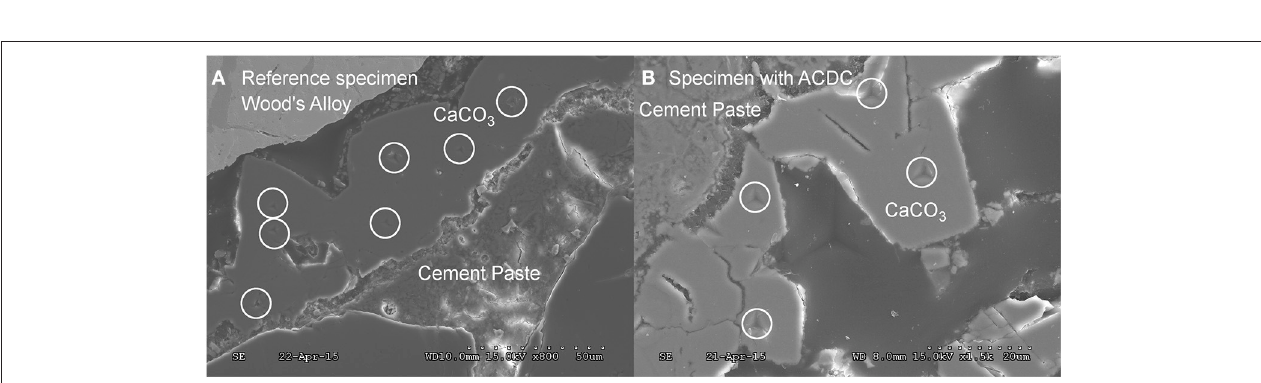
FIGURE 6 | Micrographs showing the inner crack surface of the 28 days old microbial specimen and the EDX results (A) inner crack surface appearance of microbial specimen after splitting (B) chemical composition of the minerals around the bacteria (C,D) SEM micrographs of the inner crack surface (“ ր ” indicates the individual bacterial remains, “ ◦ ” indicates the calcified ACDC cluster).